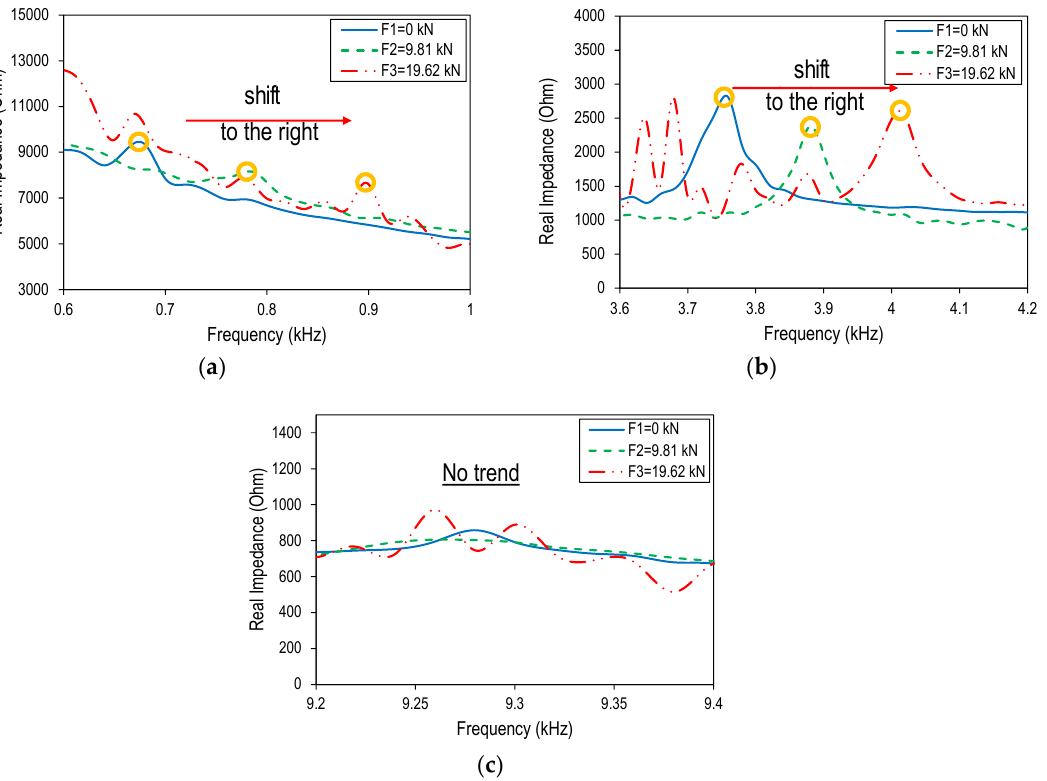
Figure 16. Shifts in experimental impedance peaks due to cable force changes: ( a ) Peak 1; ( b ) Peak 2; ( c ) Peak 3.